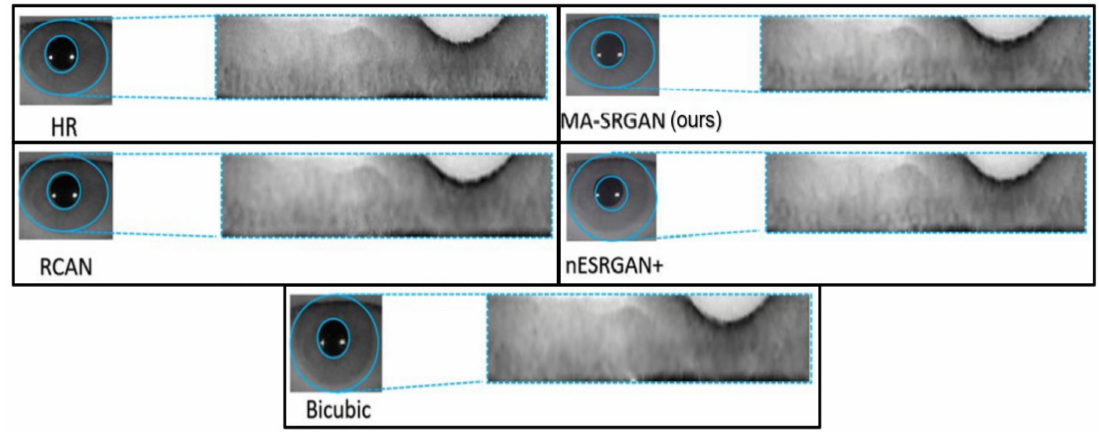
Figure 17. Visual results with Bicubic degradation ( × 4) on “Rcls6_10” from the CASIA dataset.